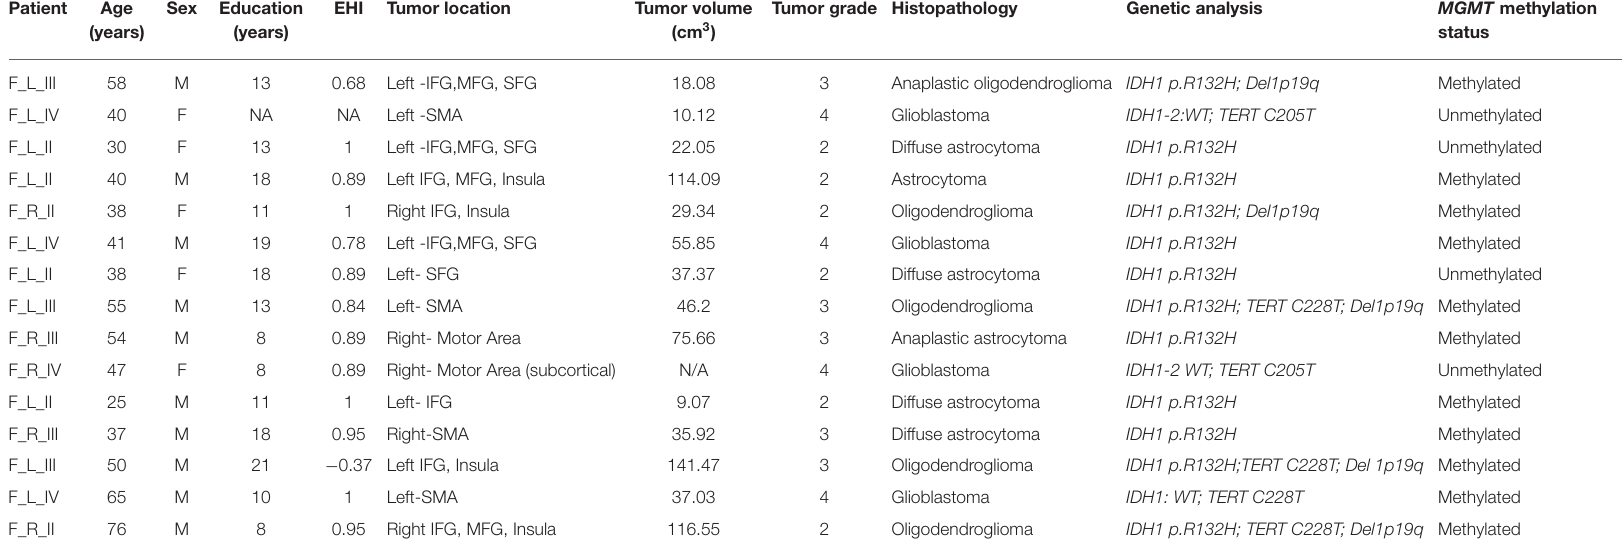
In the first column, patients are labeled according to the tumor’s (lobe)_(hemisphere)_(grade). NA, not available. EHI, Edinburgh Handedness Inventory (scores between − 1 and − 0.5 were considered indices of left-handedness; right-handedness was defined by scores between 0.5 and 1; and scores between − 0.5 and 0.5 indicated ambidextrousness). IFG, inferior frontal gyrus; MFG, middle frontal gyrus; SFG, superior frontal gyrus; SMA, supplementary motor